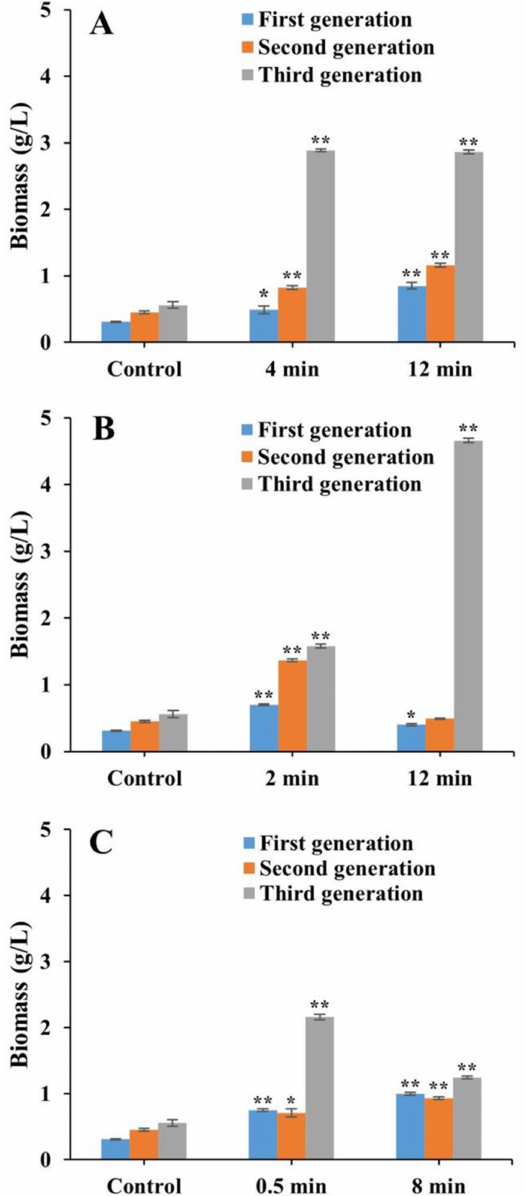
Figure 4. Biomass of laser mutants of Chlorella pyrenoidesa strain FACHB 31 treated with He–Ne ( A ), Nd:YAG ( B ), and SC ( C ) cultured under a heterotrophic condition for 21 days (three generations). Data are presented as mean ± standard errors ( n = 3). Symbols “*” and “**” indicate statistically significant differences compared to controls at p < 0.05 and p < 0.01,